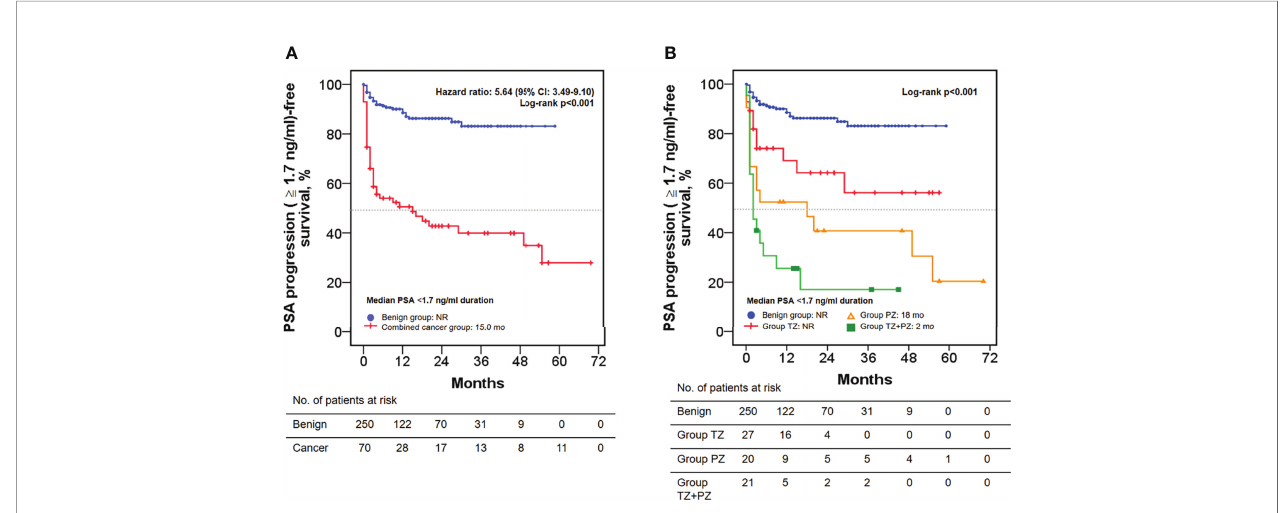
FIGURE 4 | Kaplan – Meier analysis of PSA progression-free survival in men treated by transurethral prostate enucleation. CI, con fi dence interval; mo, months; NR, not reached; PSA, prostate-speci fi c antigen; PZ, peripheral zone; TZ, transition zone.